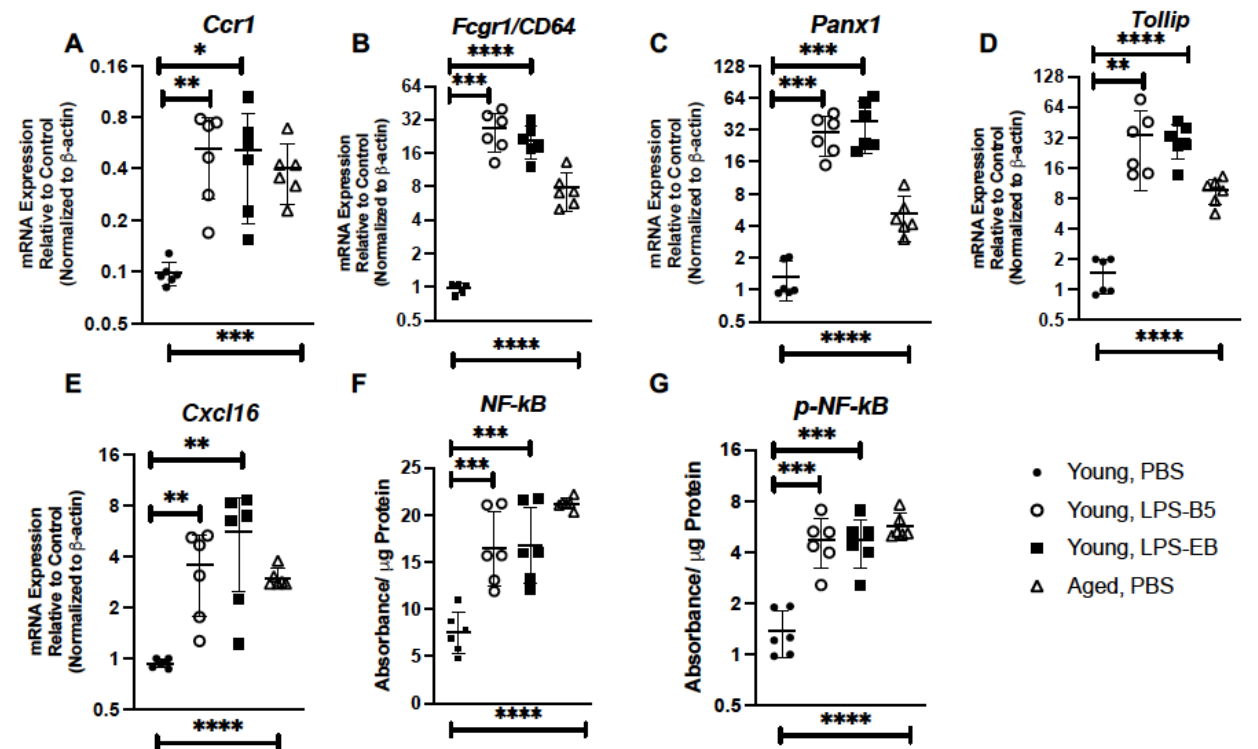
Figure 9. Treatment of Young Mice with Low-Dose LPS Alters Inflammatory Gene Expression in Lung. Lung tissue was collected from PBS-, LPS-B5-, and LPS-EB-treated young adult BALB/c mice (3 months of age). Expressions of ( A ) Ccr1 , ( B ) Fcgr1/CD64 , ( C ) Panx1 , ( D ) Tollip , and ( E ) Cxcl16 , were assessed by real-time PCR. Protein expression of ( F ) NF- κ B and ( G ) p-NF- κ B in young lung was assessed by PathScan ELISA. Aged (20 months) PBS-treated lung expression analysis is included for comparison. N = 6 mice per group, and the experiment was repeated 3 times. * p < 0.05, ** p < 0.01, *** p < 0.001, and **** p < 0.0001.